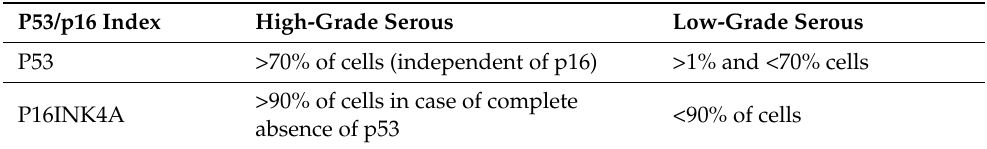
Table 1. p53/p16